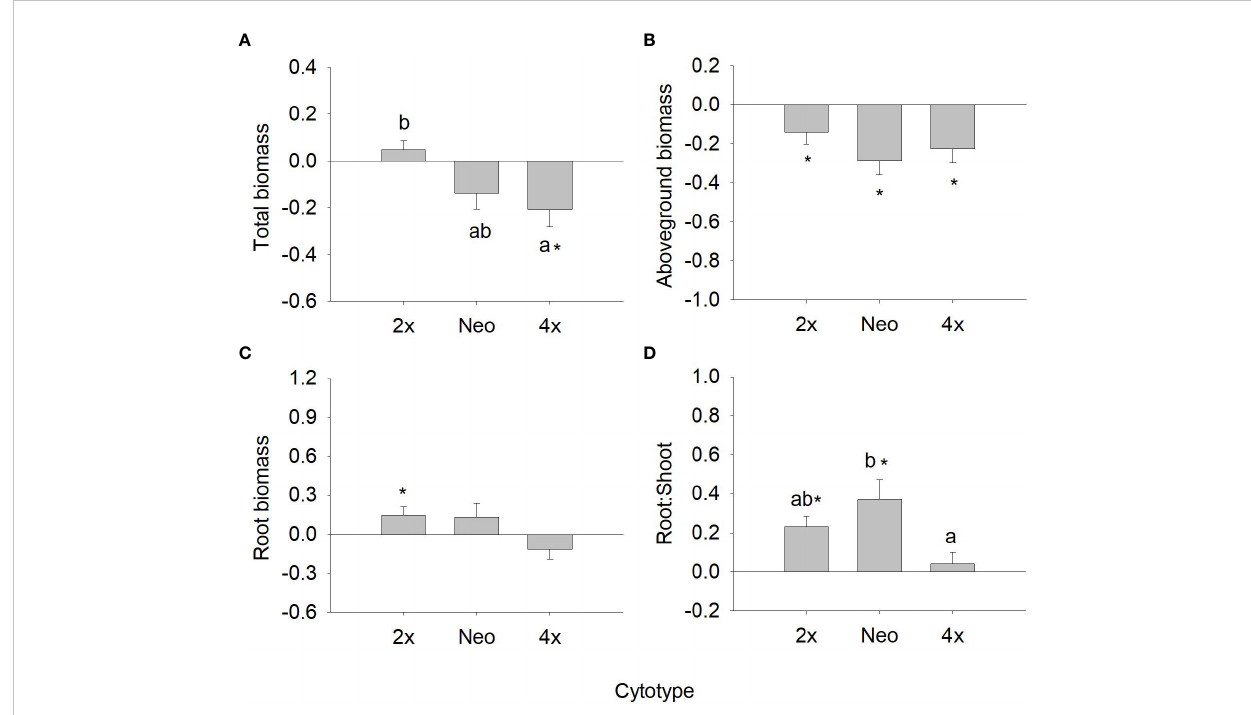
FIGURE 3 Response ratio (mean ± SE) for total biomass (A) , aboveground biomass (B) , root biomass (C) and root to shoot ratio (D) of diploids, neotetraploids and tetraploids Jasione maritima var maritima of contact zone populations. Signi fi cant differences at P < 0.05 among cytotypes are indicated by different letters. The presence of * indicates that the response ratio differed signi fi cantly from